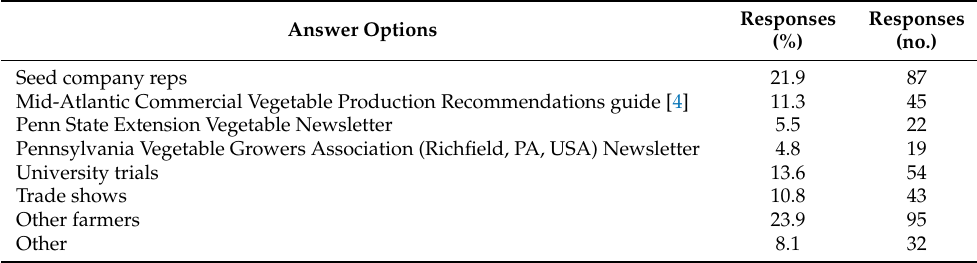
Table 2. Responses of commercial farmers at the 2019 Mid-Atlantic Fruit and Vegetable Convention in Hershey, PA, USA to the question, “How do you select cultivars?” 1 ; n = 133.